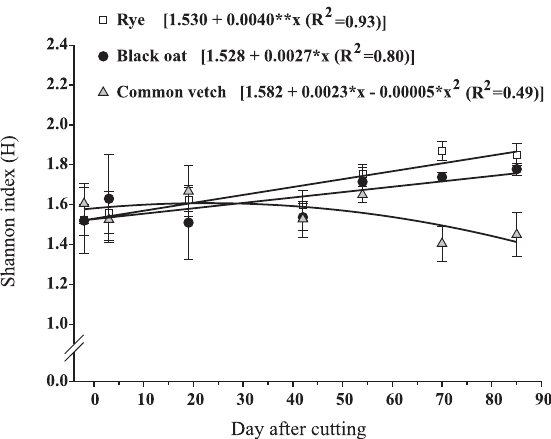
Figure 2. Shannon diversity index of soil fauna at different times during decomposition of cover plant residues in no tillage system. Error bars represent the standard error around each treatment